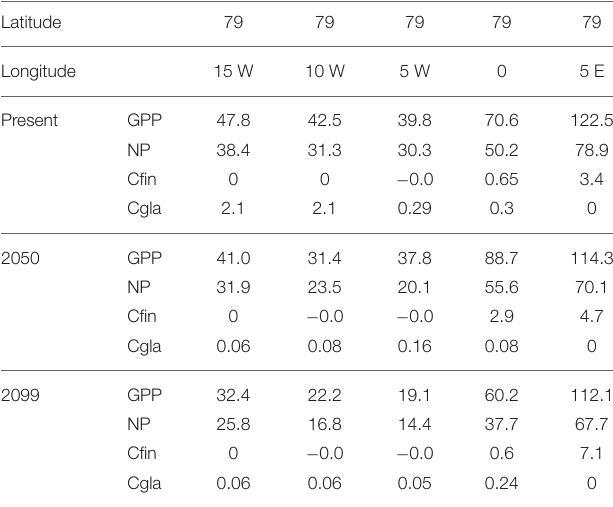
TABLE 4 | Annual Gross Primary Production (GPP), New Production (NP) and the production of Calanus finmarchicus (Cfin) and Calanus glacialis (Cgla) (g C m − 2 y − 1 ) at the various latitudes along transect B across the Fram Strait (see Figure